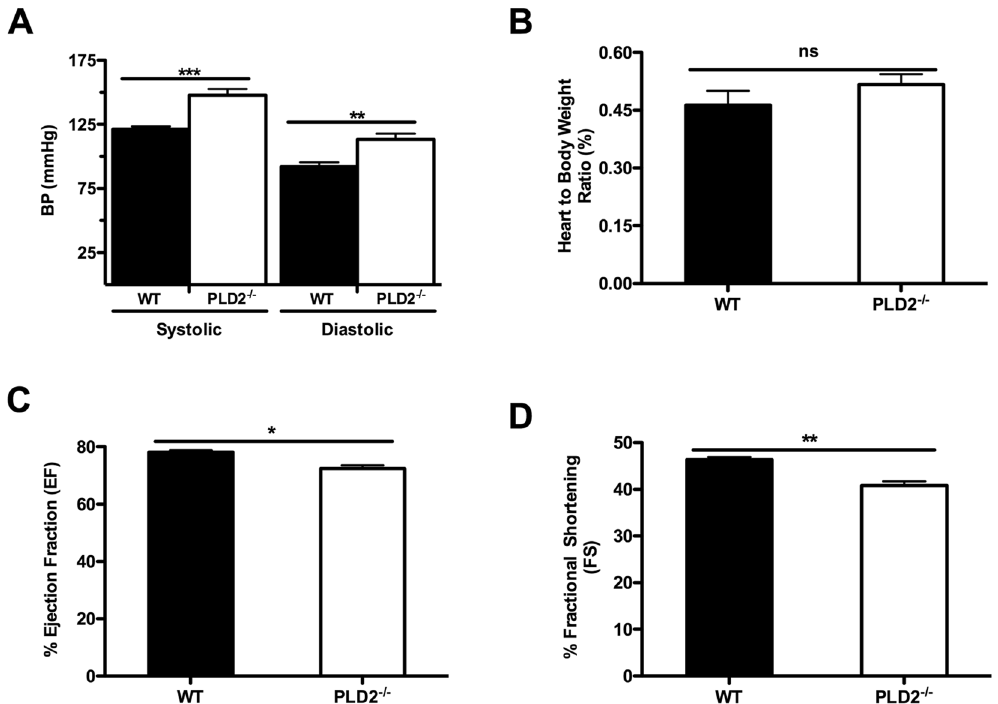
Figure 1. PLD2 − / − mice have increased BP and altered cardiac function. ( A ) A non-invasive tail-cuff instrument was used to measure systolic and diastolic blood pressure in 5-month old male mice (n = 6 mice of each genotype; each data point represents the average of 15 measurements) as described in Methods. ( B ) Heart-to-body weight ratio for PLD2 − / − and WT mice (n = 3 mice of each genotype). ( C–D ) Echocardiogram sonogram was used to determine fractional shortening (FS) and percent ejection fraction (EF) as described in Methods (n = 3). Mean ± SEM; * p < 0.05; ** p < 0.01; *** p ≤ 0.001 (Student’s